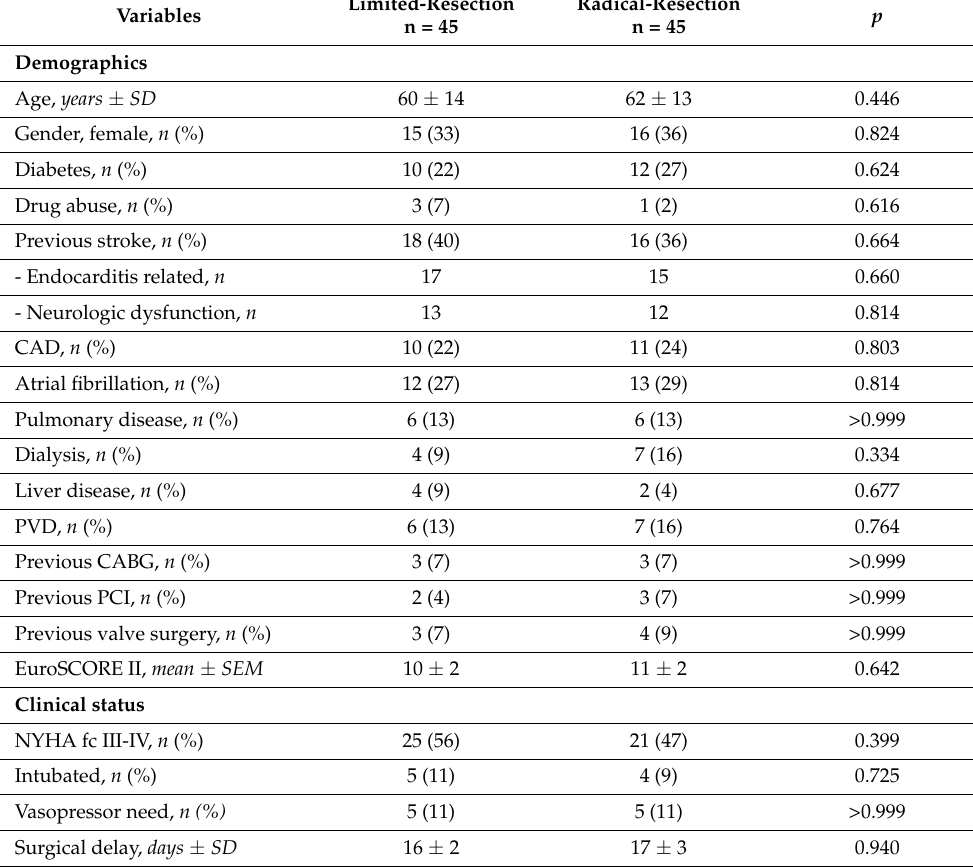
Table 1. Baseline